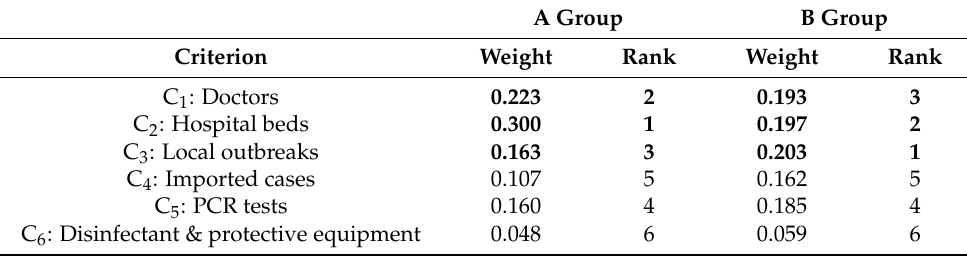
Table 7. Aggregated individual judgements and criteria ranking for each participant group.